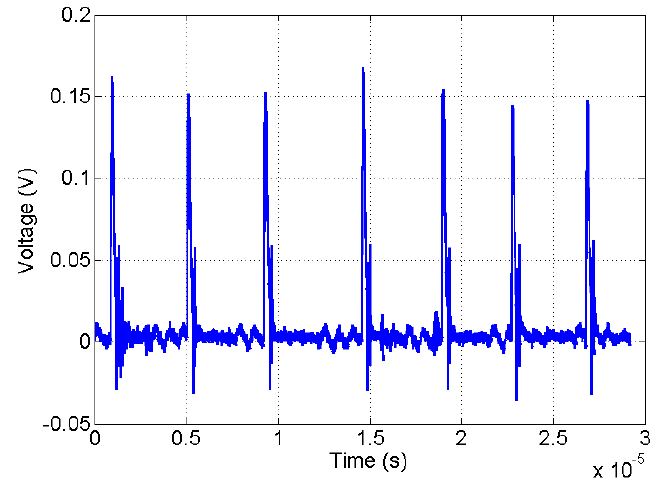
Figure 2. Typical Trichel pulse